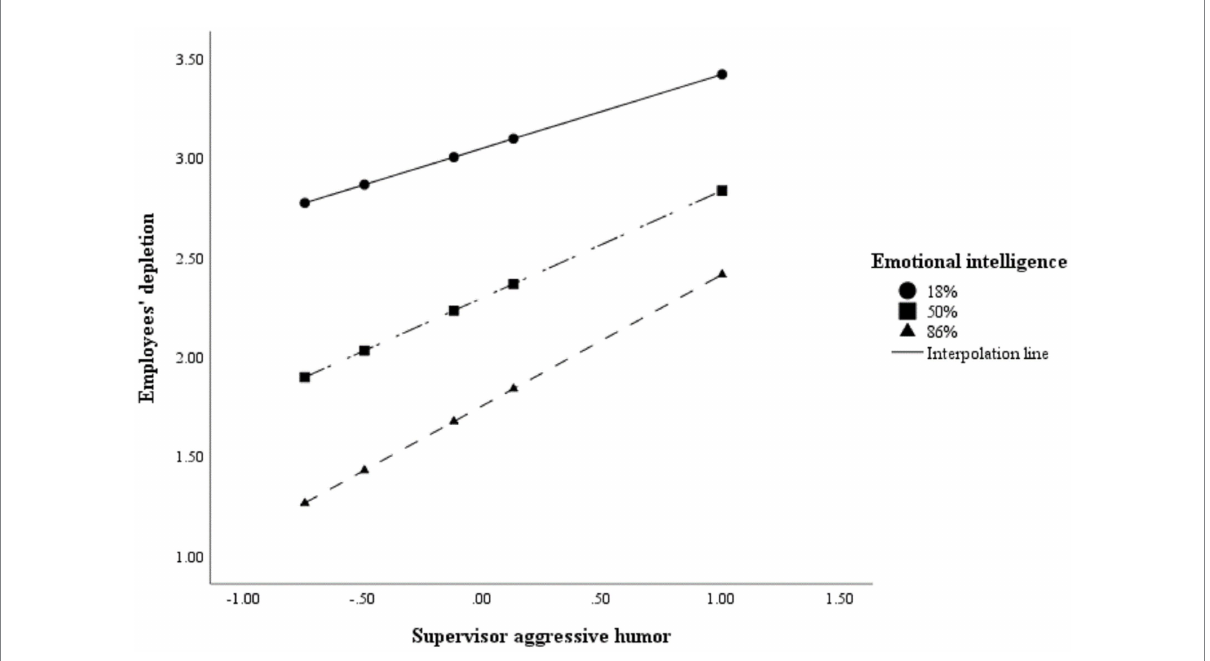
FIGURE 3 Interactive effect of supervisor aggressive humor and emotional intelligence on employees’ depletion.